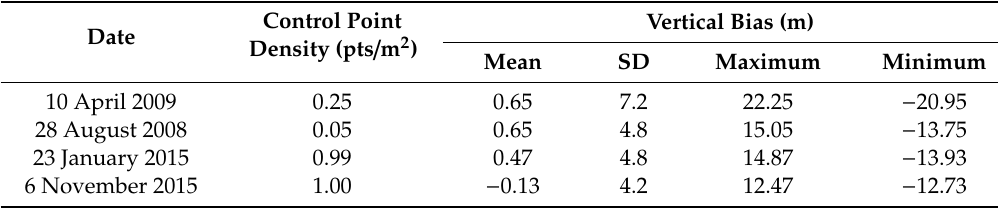
Table 2. Vertical bias between survey DEMs and LiDAR